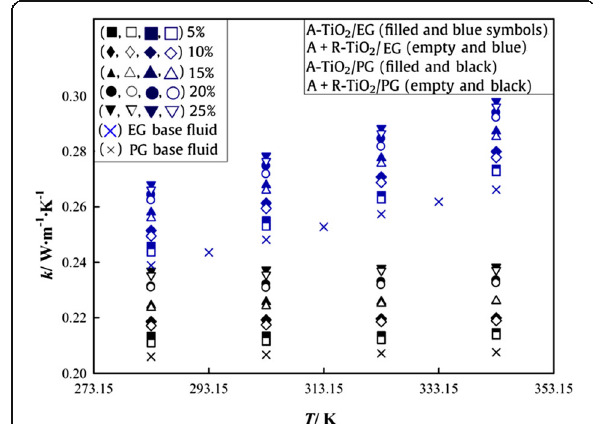
Fig. 3 Temperature dependence of the thermal conductivity of four kinds of TiO 2 nanofluids [41]. Reproduced with permission from Elsevier